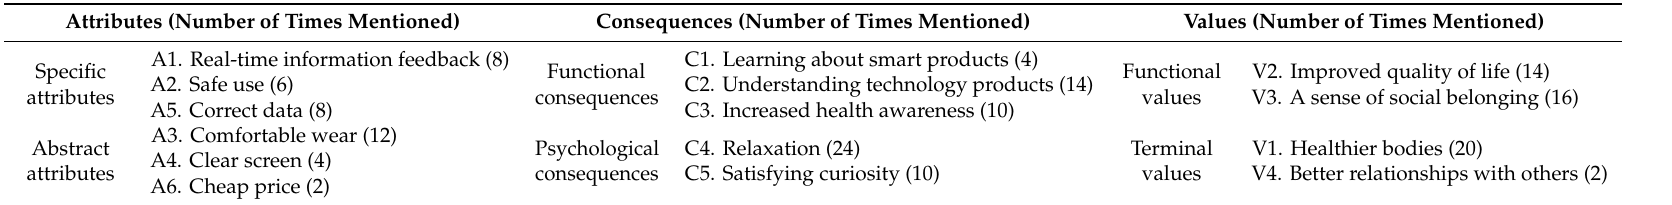
Table 5. Definitions of attributes, consequences, and